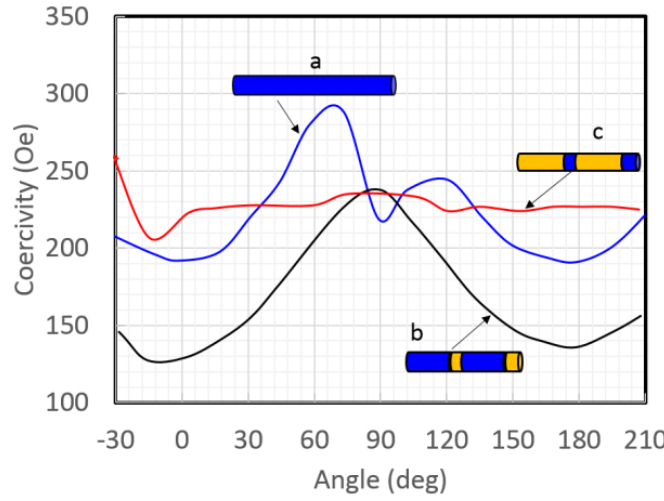
Figure 11. The coercivity from magnetic hysteresis loops for ( a ) pure Galfenol nanowires and segmented Galfenol/Cu nanowires with ( b ) 50 nm of Cu in Galfenol nanowires or ( c ) 50 nm Galfenol in Cu nanowires (diameter = 100 nm; long segments 400 and 500 nm, respectively).